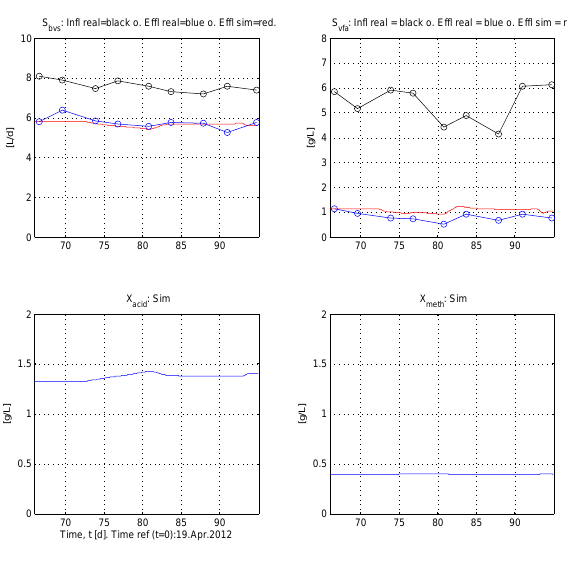
Figure 6: Upper plots: Real values (from laboratory analysis) and simulated values of the state variables S bvs and S vfa together with the respective real concentrations in the feed. Lower plots: Simulated values of the state variables X acid and X meth for which we do not have laboratory analysis